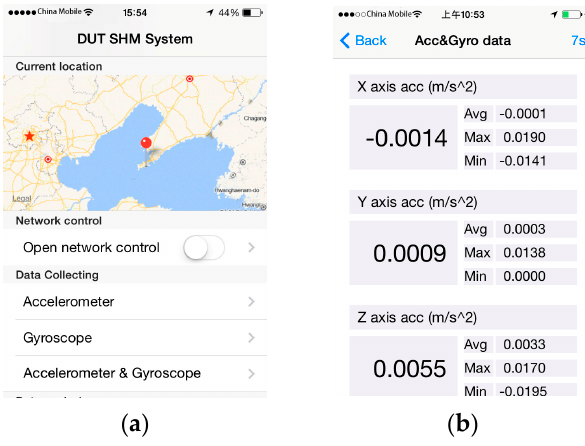
Figure 10. Collector interface of the iPhone. ( a ) GPS information; ( b ) Gyroscope interface.